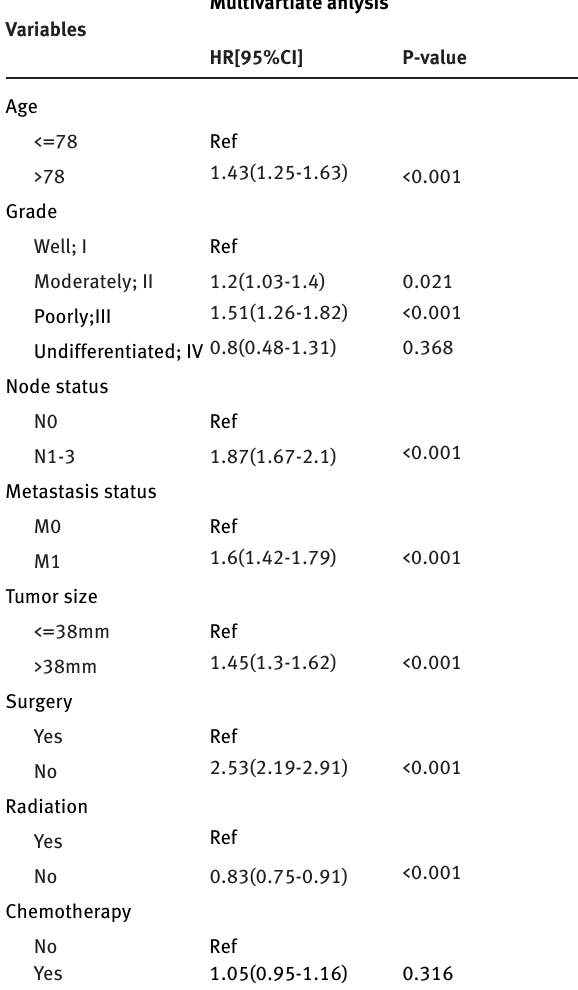
Table 3: Multivariate Cox proportional hazard analyses of clinical features for overall survival rates in patients with primary